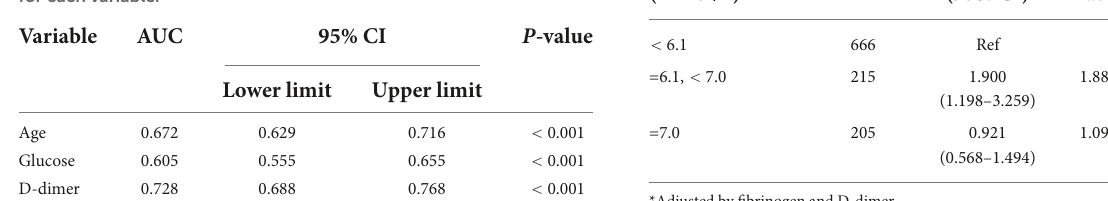
TABLE 3 The ROC and AUC to determine the optimal cut-off value for each variable.